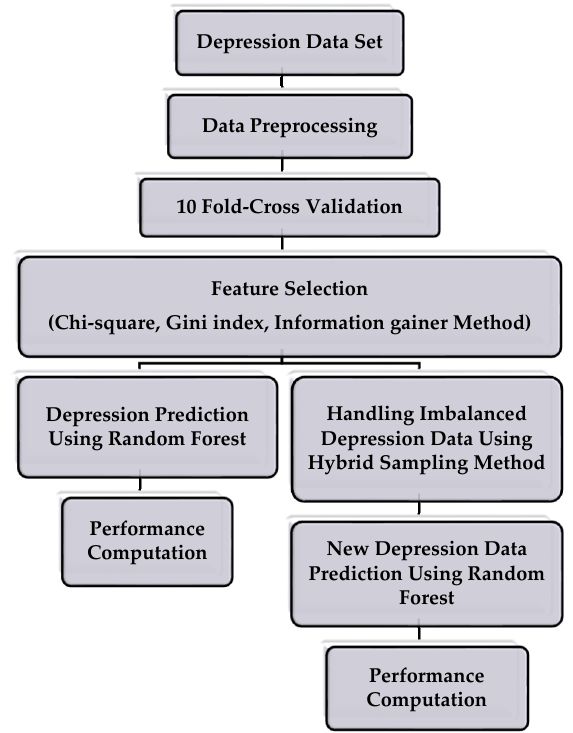
Figure 1. The proposed method to handle imbalanced depression data.